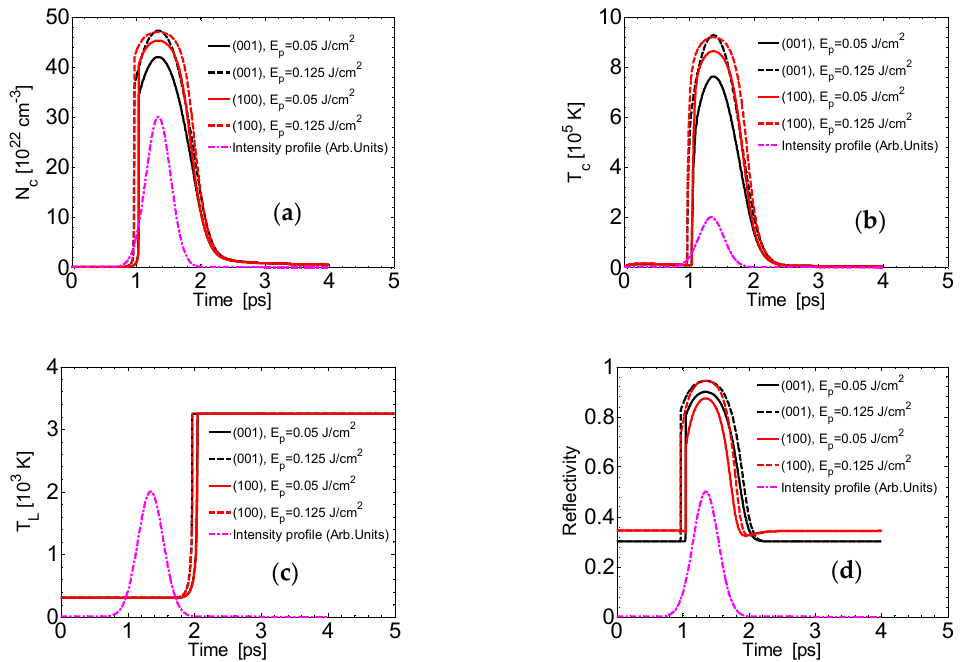
Figure 2. Evolution of values of carrier density ( a ), carrier temperature ( b ), lattice temperature ( c ) and reflectivity ( d ) for E p = 50 mJ / cm 2 and 125 mJ / cm 2 for (001) and (100) crystal orientation at x = y = 0 and on the surface of the material.